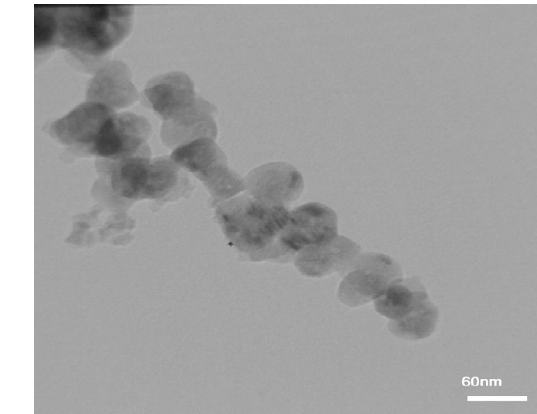
Fig. 4. TEM micrograph of the α -Fe 2 O 3 NPs.